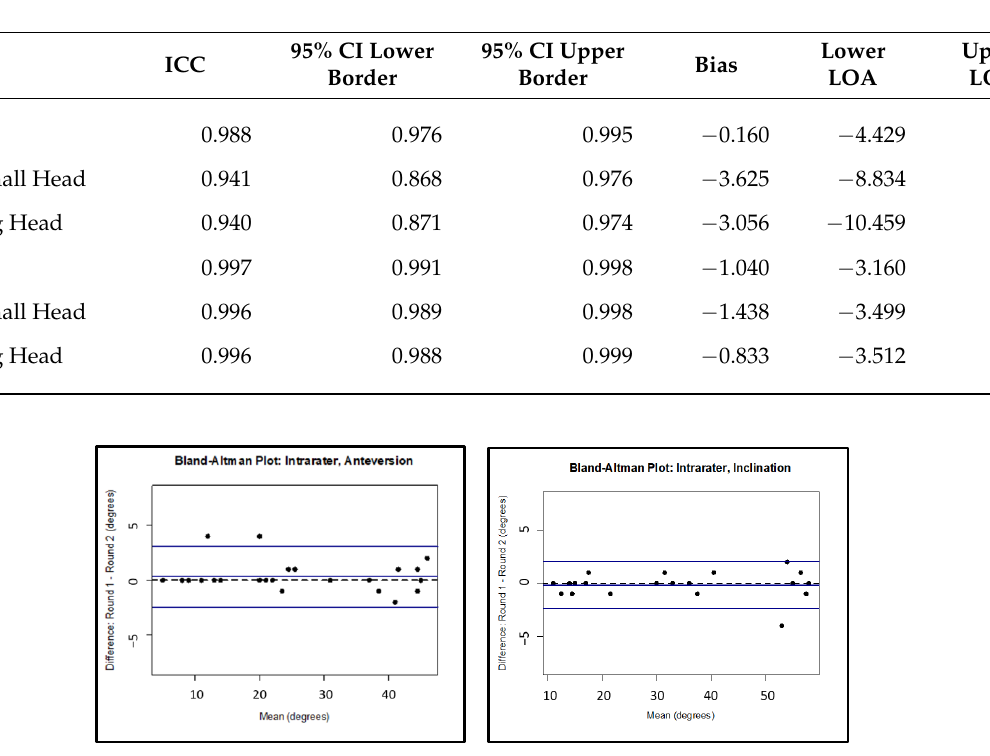
presented in Figure 6. Table 2. Complete interrater analysis including interclass correlation coefficient (ICC) and Bland– Altman bias and limits of agreement (LOA).